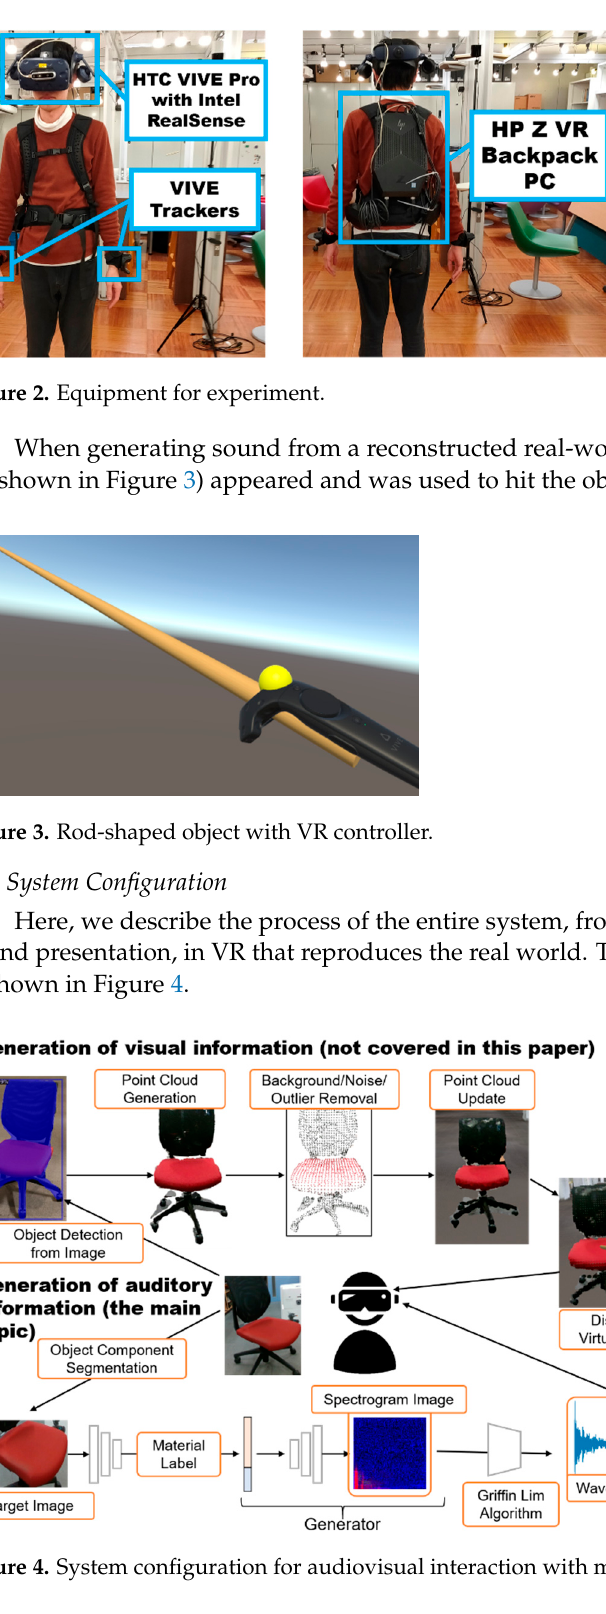
Figure 1. HTC VIVE Pro with RealSense.